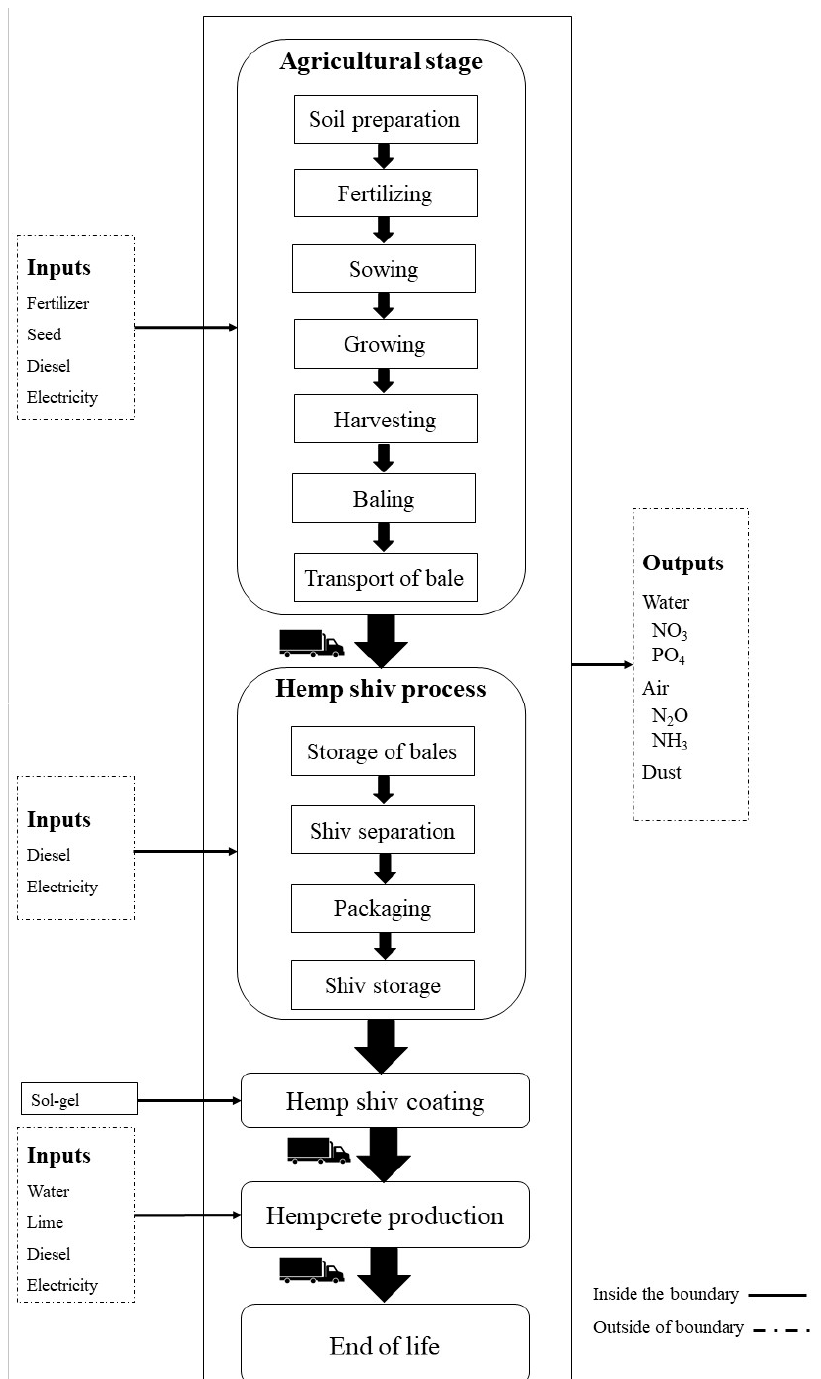
Figure 1. Life cycle and system boundaries of the hempcrete production.